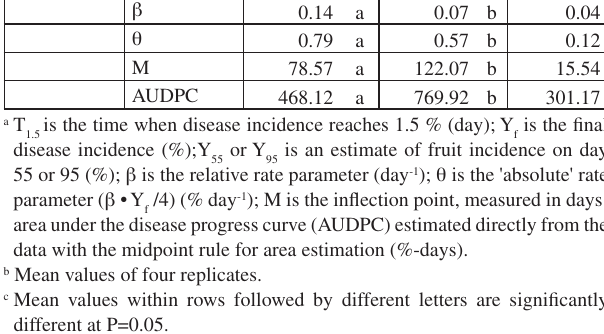
disease incidence (%);Y or Y is an estimate of fruit incidence on day 55 95 55 or 95 (%); b is the relative rate parameter (day -1 ); q is the 'absolute' rate parameter ( b • Y /4) (% day -1 ); M is the inflection point, measured in days; f area under the disease progress curve (AUDPC) estimated directly from the data with the midpoint rule for area estimation (%-days). b Mean values of four replicates.